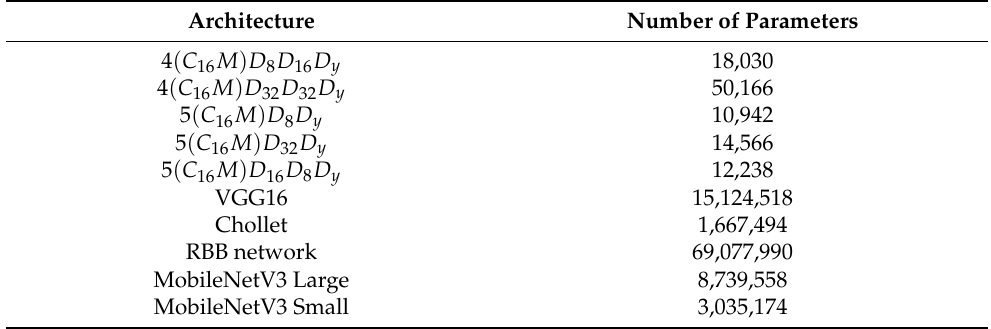
Table 1. Structure of the architectures considered in this paper, along with their total number of trainable parameters. The final dense layer D y is either D 2 or D 6 , for binary and multi-class classification, respectively. We remark that we used a pre-trained version of VGG16, where we only re-trained the final layer of the network to match our